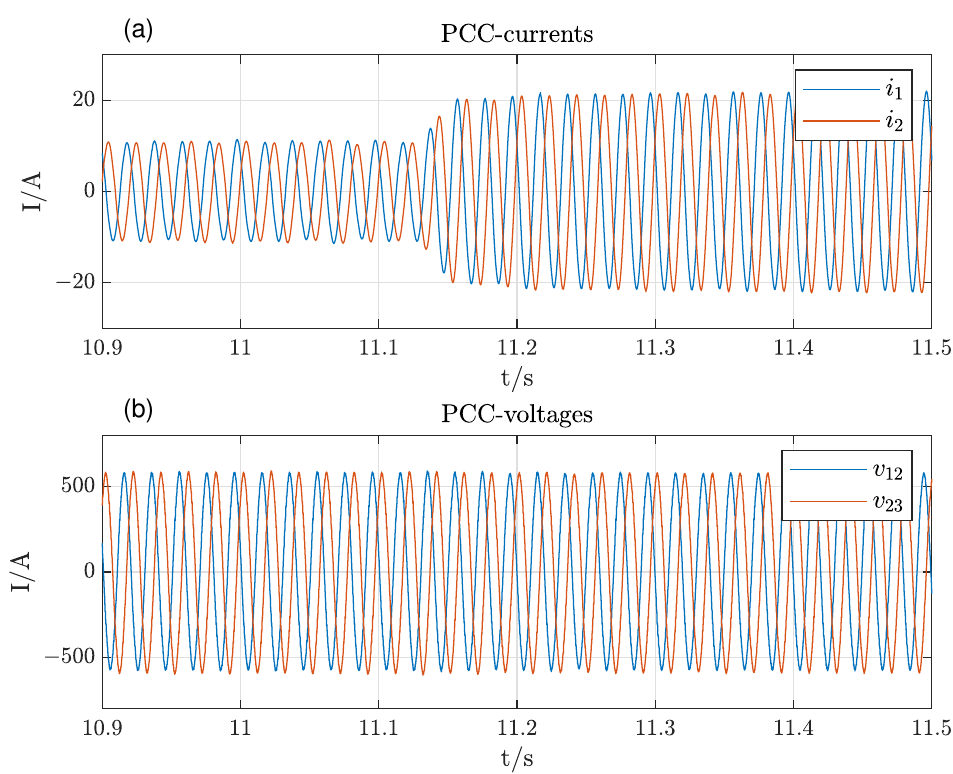
Figure 9. Load step change in grid-tied condition: ( a ) PCC-currents and ( b ) PCC-voltages. The ability to operate at varying rotor speeds and, thereby, slips is shown in Figure 10. The mechanical speed has been changed from 10% supersynchronous speed to 10% subsynchronous speed within 2.5 s. Stator and rotor currents do not show any disruptive transients during these significant speed changes.